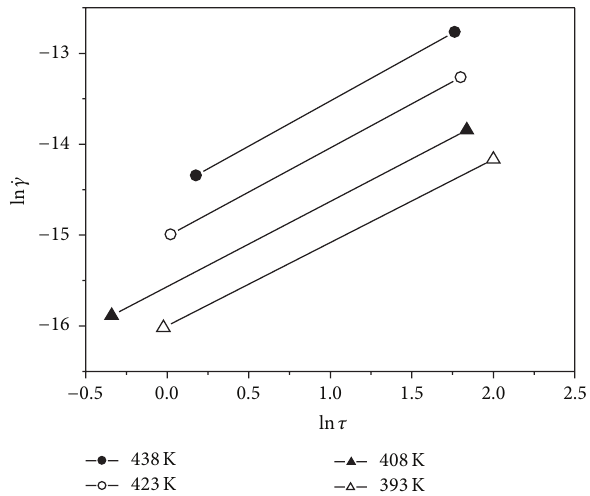
Figure 13: The correlation between the logarithm of strain rate and average stress for the shear creep test.